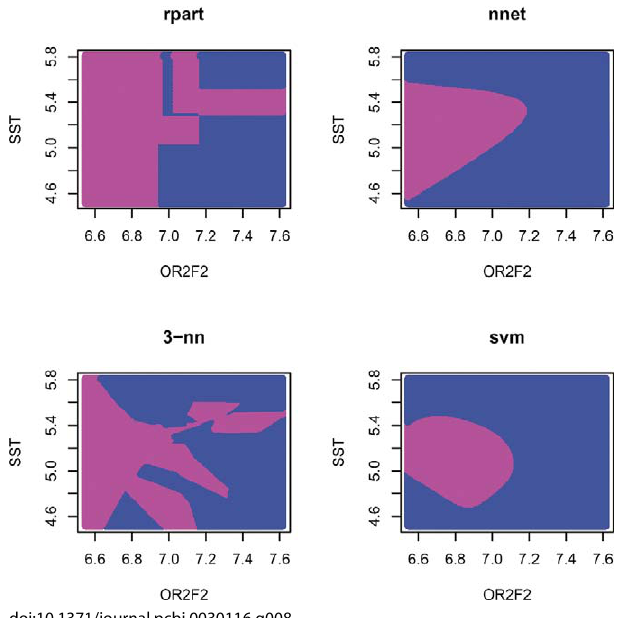
Figure 8. Display of Four Two-Gene Classifiers Top left: CART with minsplit tuning parameter set to 4; top right: a single-layer feed-forward neural network with eight units; bottom left, k ¼ 3 nearest neighbors; bottom right, the default SVM from the e1071 package. The planarPlot function of the MLInterfaces package can be used to construct such displays. If the expression level of a given sample falls into the magenta-colored area, then the sample is predicted to have status NEG; if it falls into the blue-colored area, then the sample is predicted to have BCR/ABL